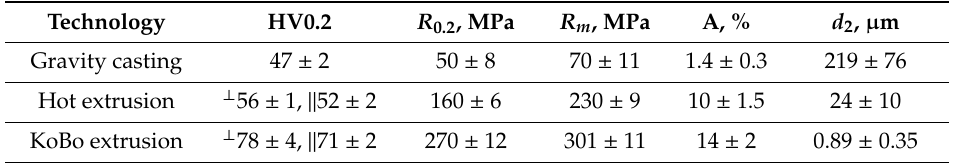
Table 1. Mechanical properties and equivalent Mg( α ) grain diameter of Mg-Csf composite processed by different technologies.